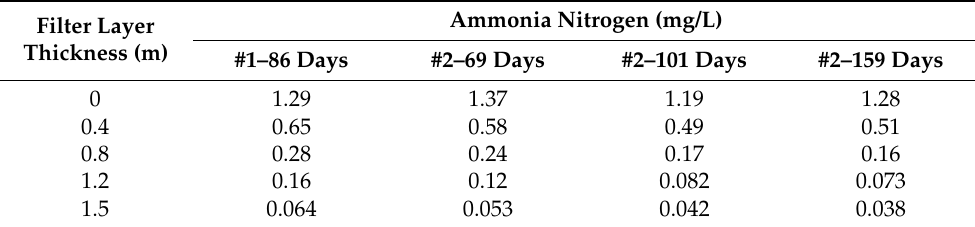
Table 4. Variations in ammonia along the filter layer at different stages.